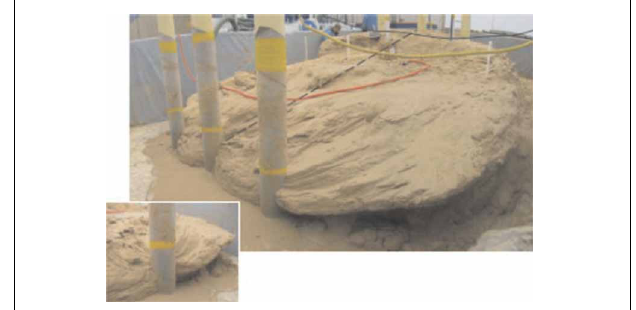
FIGURE 4 | Image of a cemented sand body from a large scale biogrout experiment.Van Paassen et al. (2010).